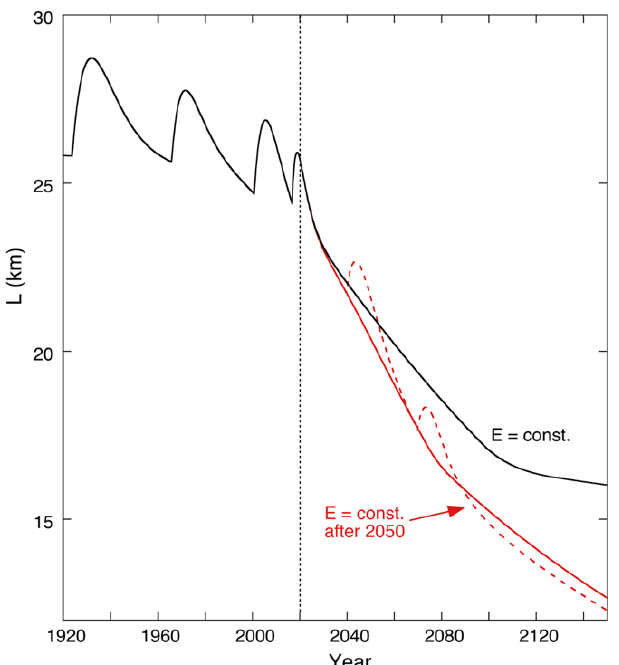
Figure 10. Glacier length L for the “Paris run” (constant ELA af- ter 2050), shown in red. The black curve refers to the calculation in which E is kept constant at its 2020 reconstructed value (as in Fig. 9). The dashed curve represents the Paris run with two surges imposed, starting in 2040 and 2070.